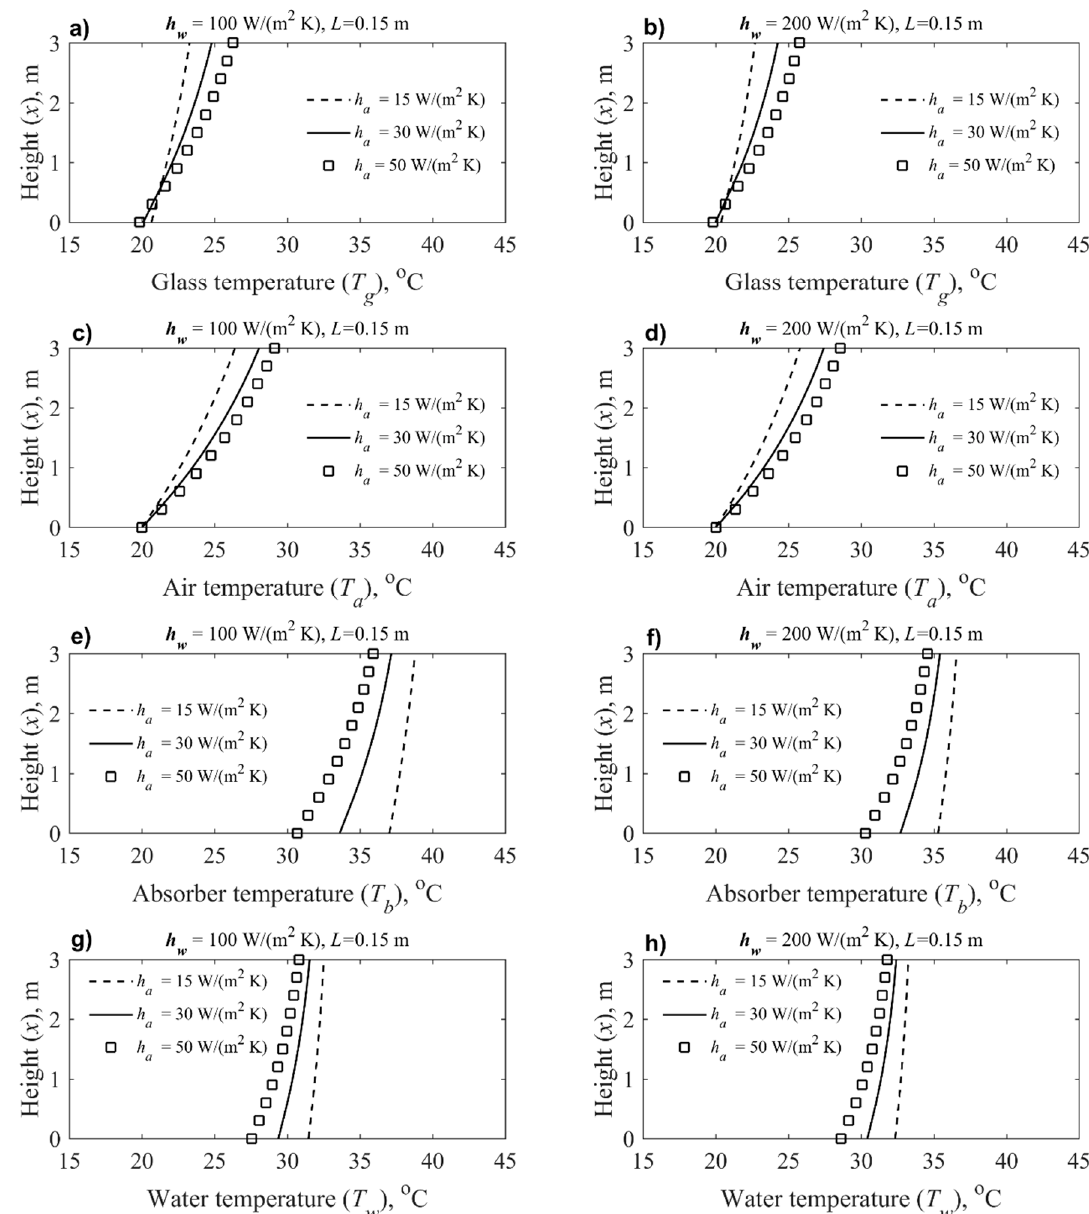
Figure 7. The temperature variations of the different elements of the system: ( a , b ) glass temperature; ( c , d ) air temperature; ( e , f ) absorber temperature; ( g , h ) water temperature as a function of the system height for the tank of 0.15 m in width, after 5 h. Subfigures ( a , c , e and g ) are obtained for h w = 100 W/(m 2 ·K) while ( b , d , f and h ) for h w = 200 W/(m 2 ·K).